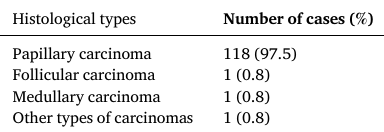
Table 3 Incidentalomas histological